Question: Based on the figure, does the quantity rise or fall?
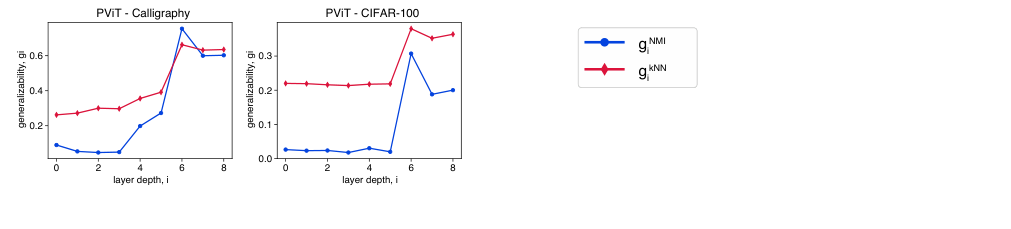
Answer: increasing